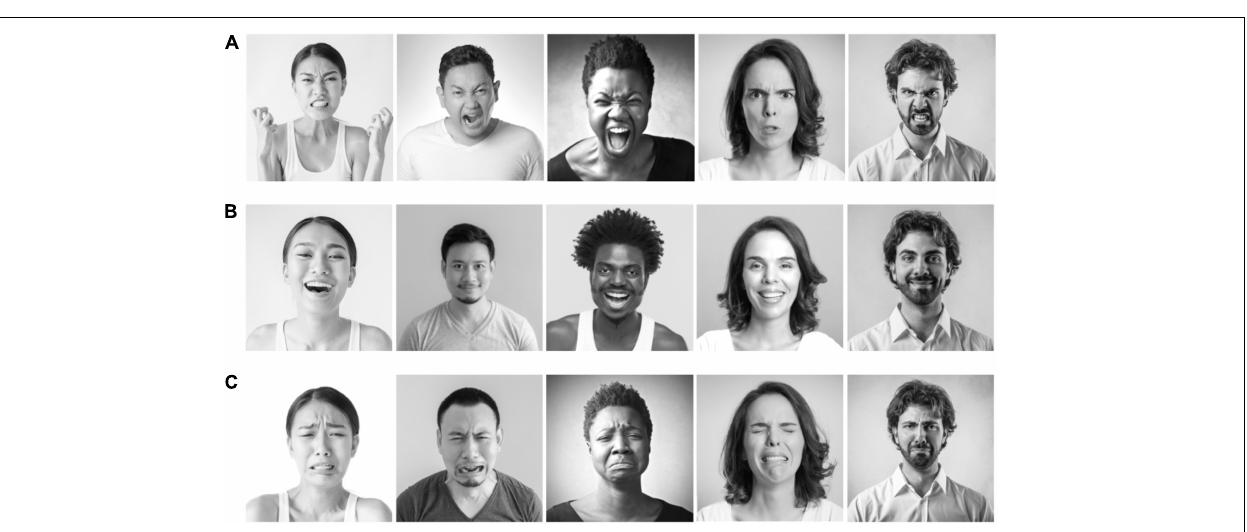
η 2 = 0.21, observed power = 1.00. There was also a significant p country × context × expression interaction, F (2, 569) = 16.26, = 0.02, observed power = 0.86, that revealed p < 0.001, η 2 p South Korean participants in the smile condition interpreted positive vignettes as more intense than negative vignettes.